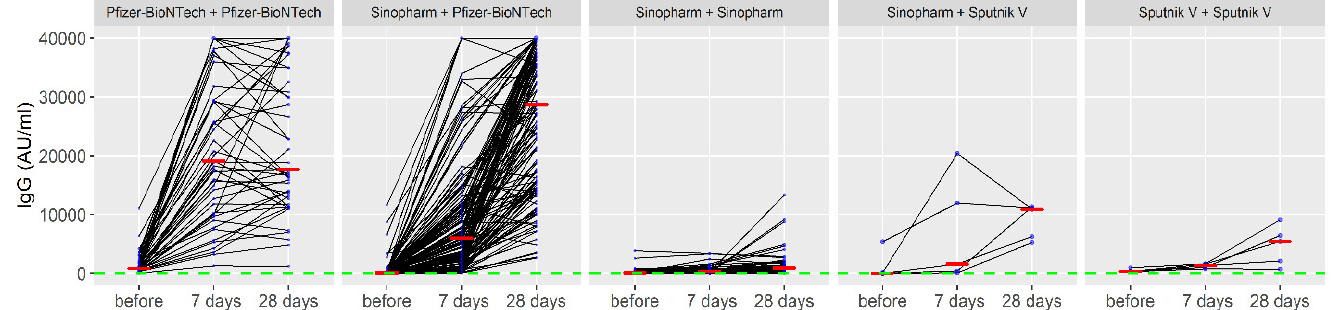
Figure 2. Titers of anti-spike immunoglobulin G in applied vaccine combinations (primary vaccina- tion series and booster dose) during the observed period. The red line represents the median IgG values; the blue circle represents the number of cases with the same IgG values. Table 3. Univariate and multivariate analysis of the decrease in IgG values 28 days after the booster dose compared to 7 days after the booster dose of COVID-19 vaccines ( n =